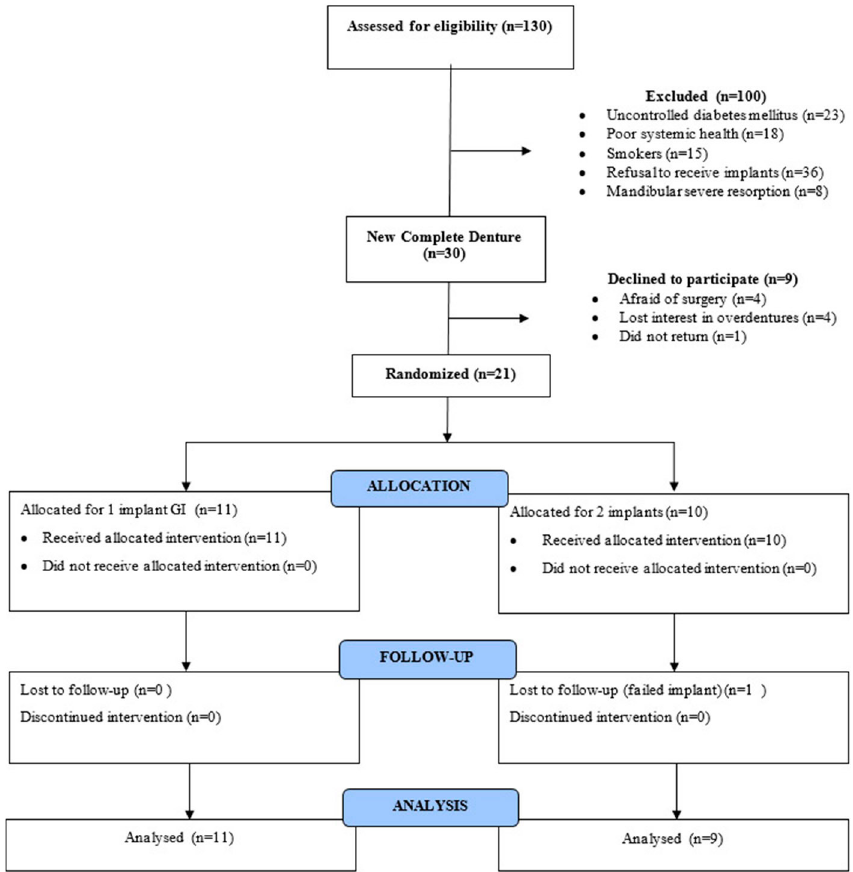
Figure 1- Flowchart of